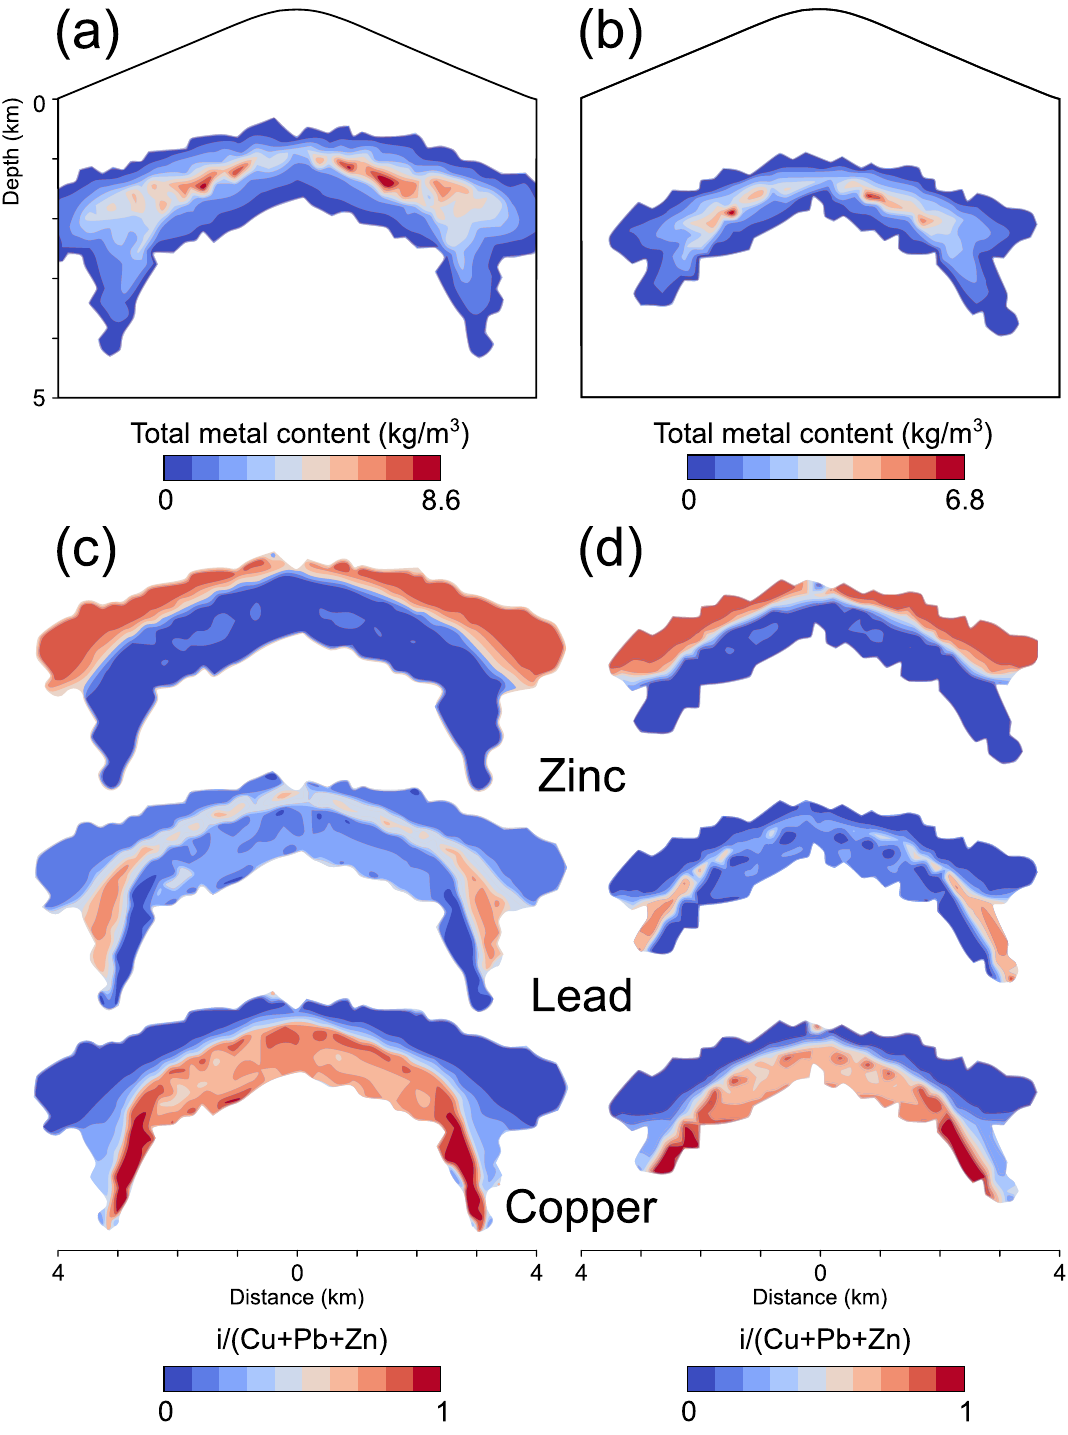
Figure 7. Total modeled metal content after 100 kyrs of simulation time above a threshold of 0.5 kg/m 3 (sum of the copper, lead and zinc contents) for the simulations 4 ( a ) and 5 ( b ). Individual metal fractions within these areas of enrichment illustrate the modeled base metal zonation ( c , d